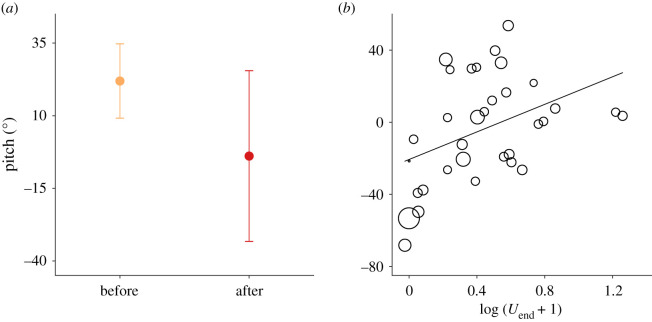
(a) Body pitch of flies (N = 33) prior to (orange symbols) and after (red symbols) interacting with the waterfall. Data points represent means ± one standard deviation. (b) Body pitch versus log (horizontal speed + 1) following passage through the waterfall; circle sizes represents relative body size. The regression is given by: pitch = 38 log (Uend + 1) − 21 (r2 = 0.2, F31 = 6.7, p = 0.01).